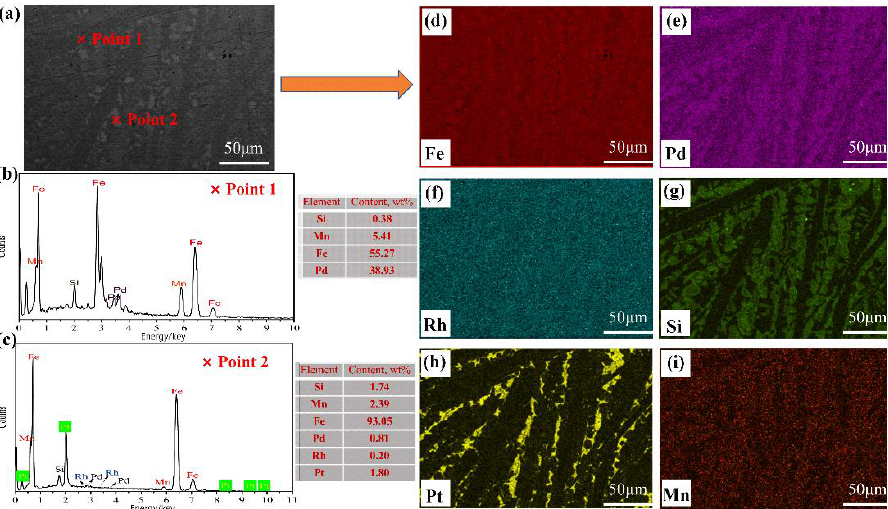
Figure 6. The profile of obtained PGM-bearing alloys observed via SEM ( a ), EDS component analysis at different regions for point 1 and point 2 ( b , c ), mapping images of Fe, Pt, Pd, Rh, Si, and Mn ( d – i ).